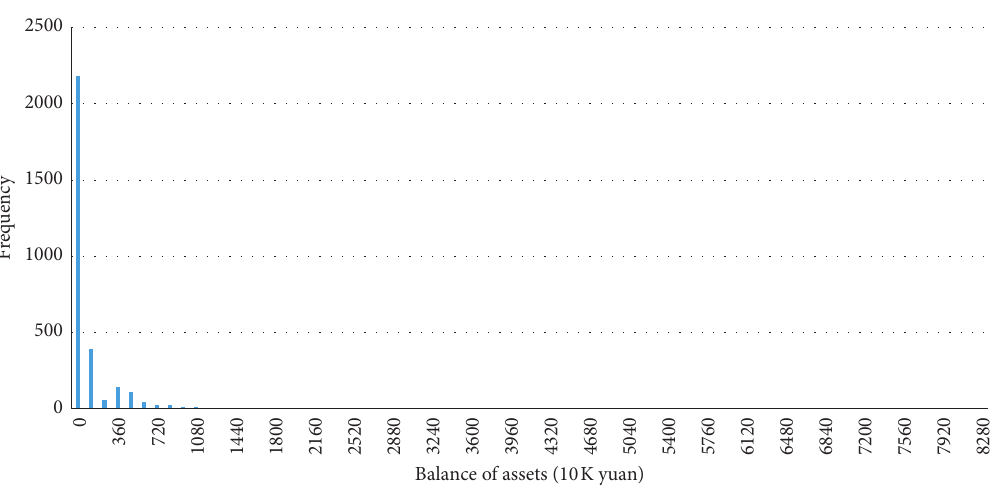
Figure 3: Distributions of assets in the parent pool: balance of